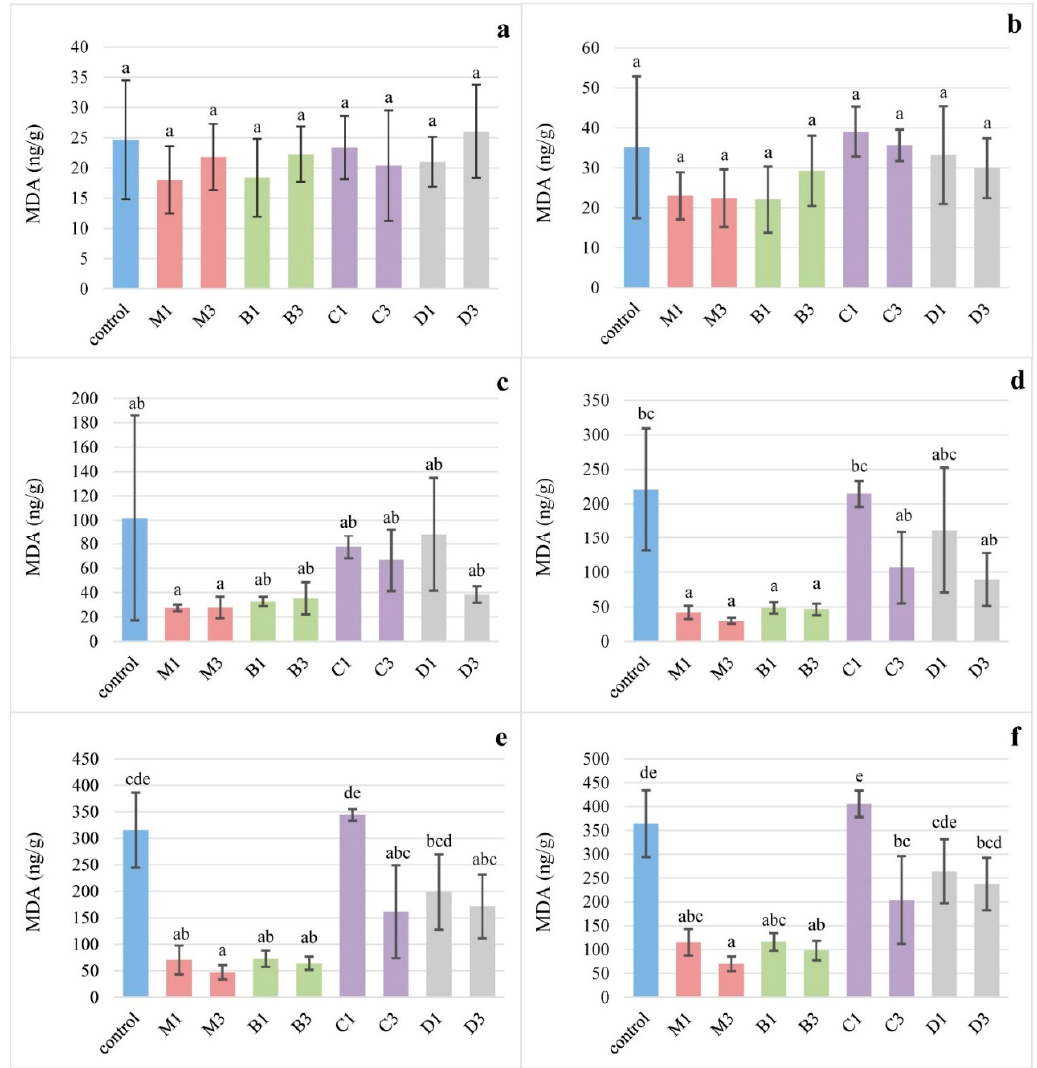
Figure 1. Iron-induced MDA concentration in egg yolks from hens fed diets differentiated in pigment supplementation (B1 and B3—1% and 3% basil herb; C1 and C3—1% and 3% calendula flower; D1 and D3—1% and 3% dandelion flower; and M1 and M3—1% and 3% marigold flower) during incubation from 0 to 250 min (( a )—0 min, ( b )—50 min, ( c )—100 min, ( d )—150 min, ( e )—200 min, ( f )—250 min). The error bars show the standard deviations for each treatment, and values at each incubation time with different letters differ significantly ( p < 0.05).